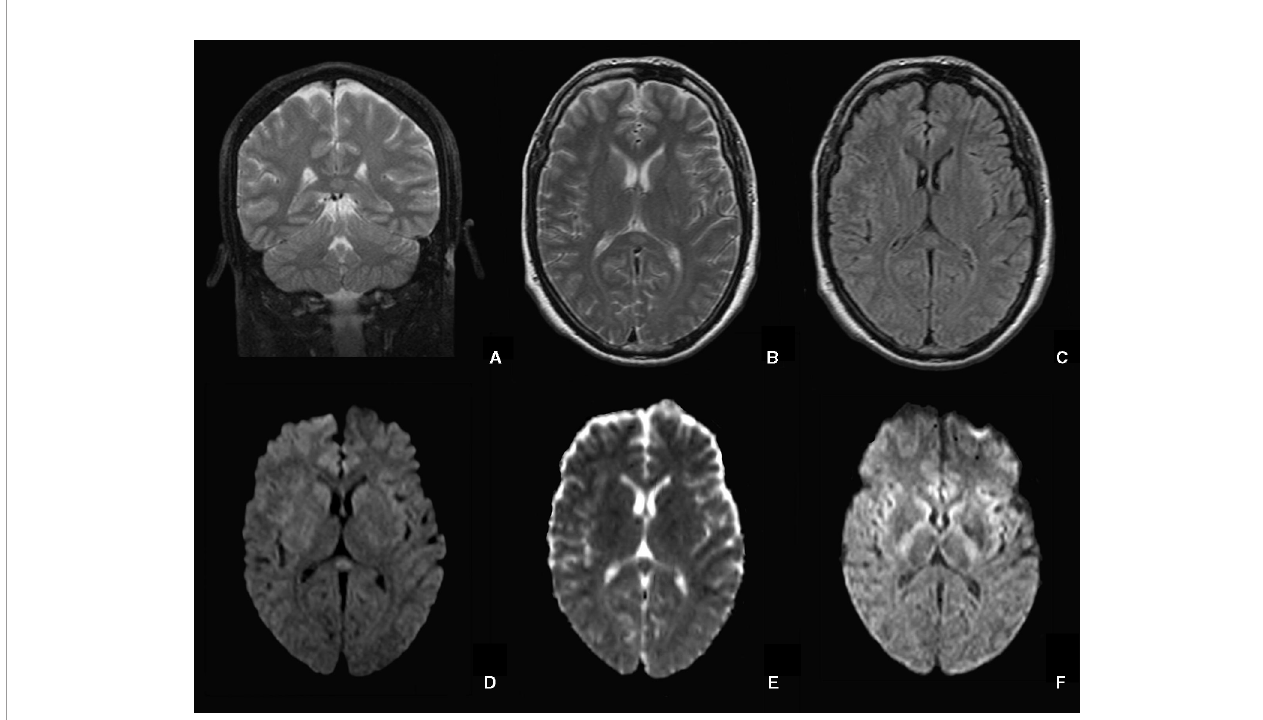
FIGURE 1 | Transient focal lesion in the SCC. Coronal and axial T2-weighted images (A, B) and axial FLAIR (C) showed an oval hyperintense focal lesion in the SCC. On axial DWI (D) the lesion is hyperintense with low values on the ADC map (E) . After 2 weeks, the lesion is no longer detectable on DWI (F)